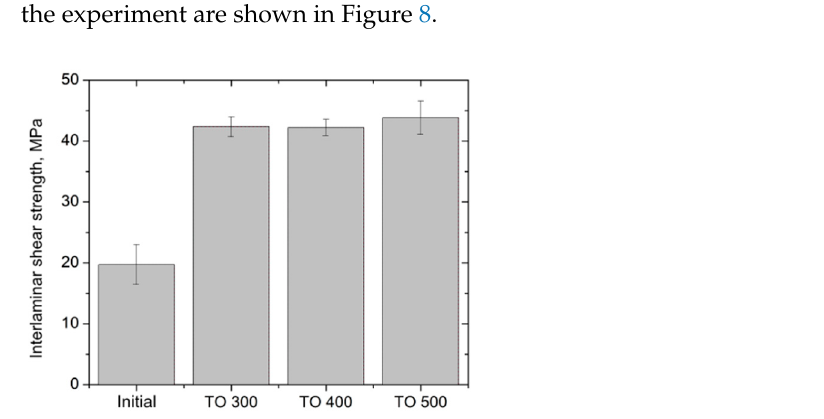
Figure 8. Results of interlaminar shear strength test of 50/50 composites reinforced with modified carbon fibers.